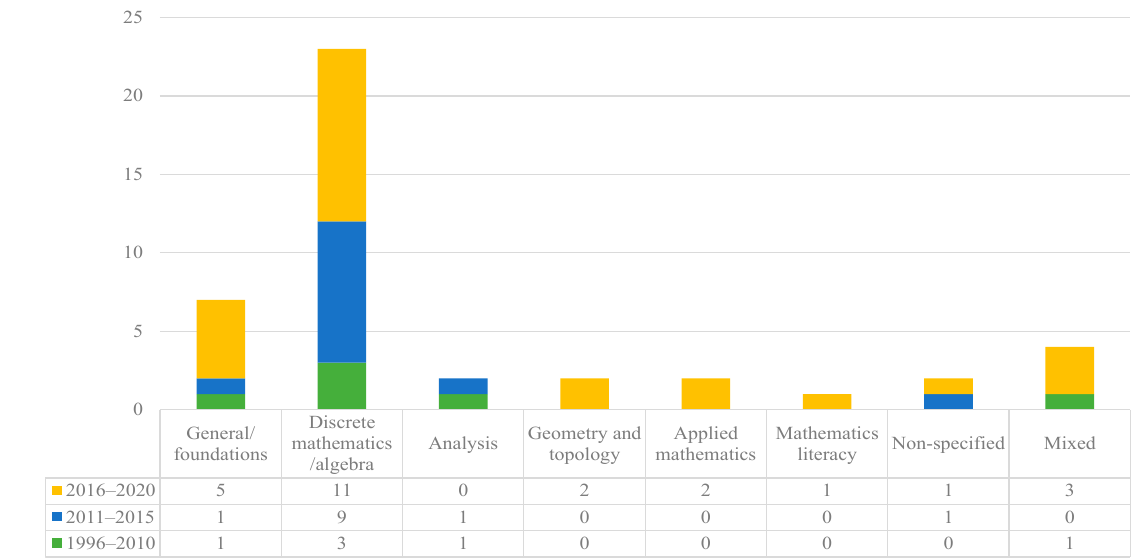
Figure 8. Application domains of AIME research in each period.